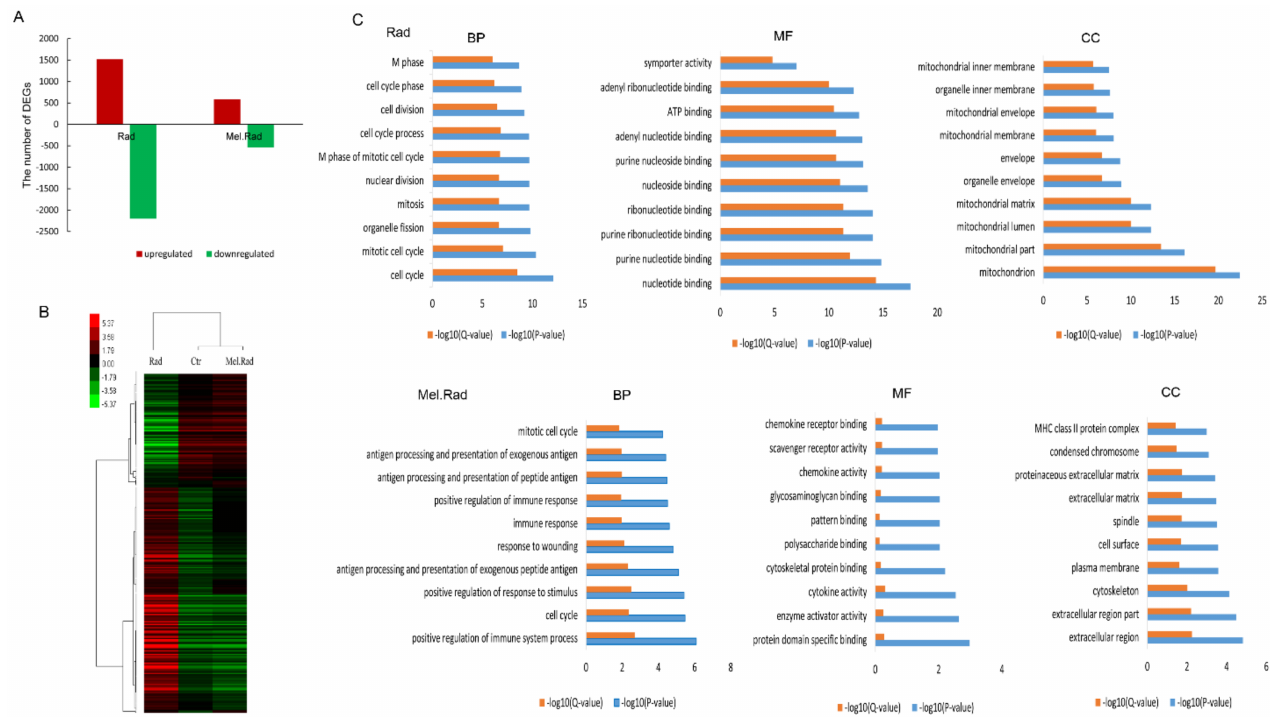
Figure 4. The gene expression profile of the small intestine from mice following ABI. Mice were treated with melatonin (10 mg/kg) daily for 5 consecutive days by intraperitoneal injection before exposure to a dose of 14 Gy ABI. The small intestines were harvested at 3 days after radiation and DNA microarray analysis was performed. ( A ) The number of upregulated DEGs and downregulated DEGs for mice. The red-and-green chart shows the upregulated DEGs (red) and the downregulated DEGs (green). ( B ) Cluster analysis of similarity of genome-wide expression for mice. Every row represents a piece of chip; every line represents a gene probe. The red and green levels of probe signals indicate the level of upregulation (red) or downregulation (green). ( C ) Significantly enriched GO analysis (top10) of the DEGs for mice. The values of − log10 ( p -value) and − log10 (Q-value) show the relationship between gene expression and the relevant GO category. The y -axis represents the GO category and the x axis the − log10 ( p -value) and − log10 (Q-value). n = 3